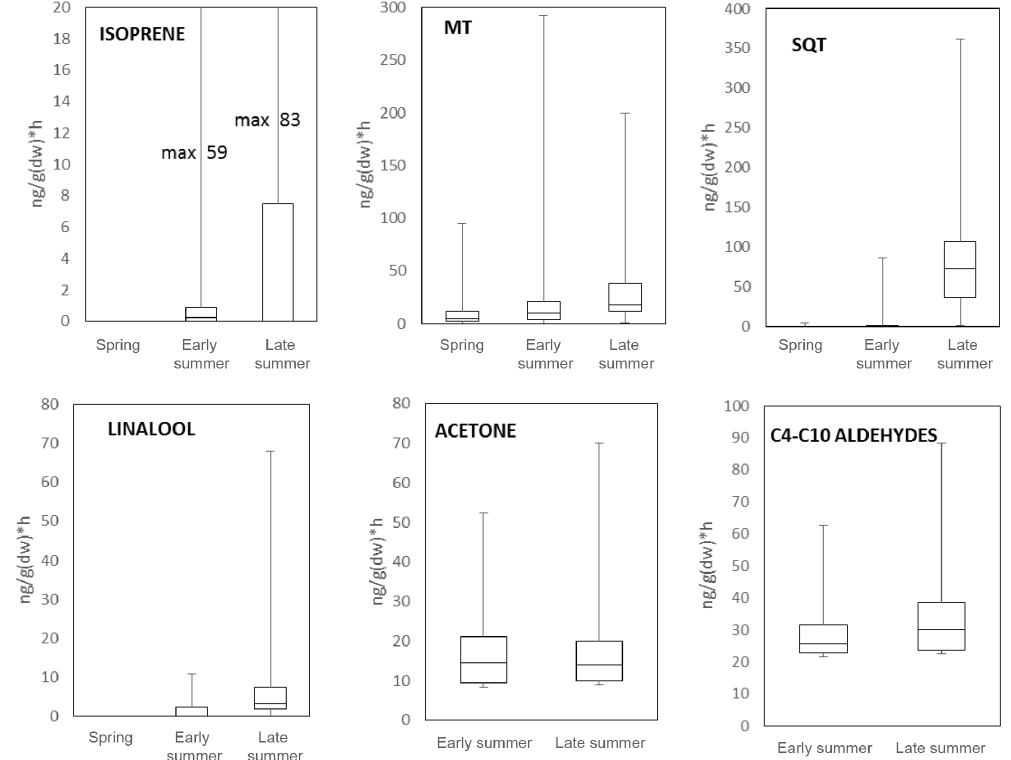
Figure 2. Season mean box and whisker plots of isoprene, MT, SQT, acetone, C 4 –C 10 aldehydes (butanal, pentanal, hexanal, heptanal, octanal, nonanal, and decanal) and linalool. Boxes represent second and third quartiles and vertical lines in the boxes median values. Whiskers show the highest and the lowest